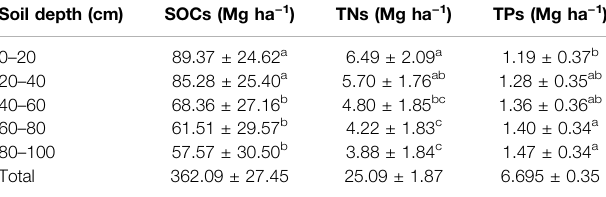
TABLE 6 | The mean SOC, TN, and TP stoichiometry in different soil depths of 0 – 100 cm.